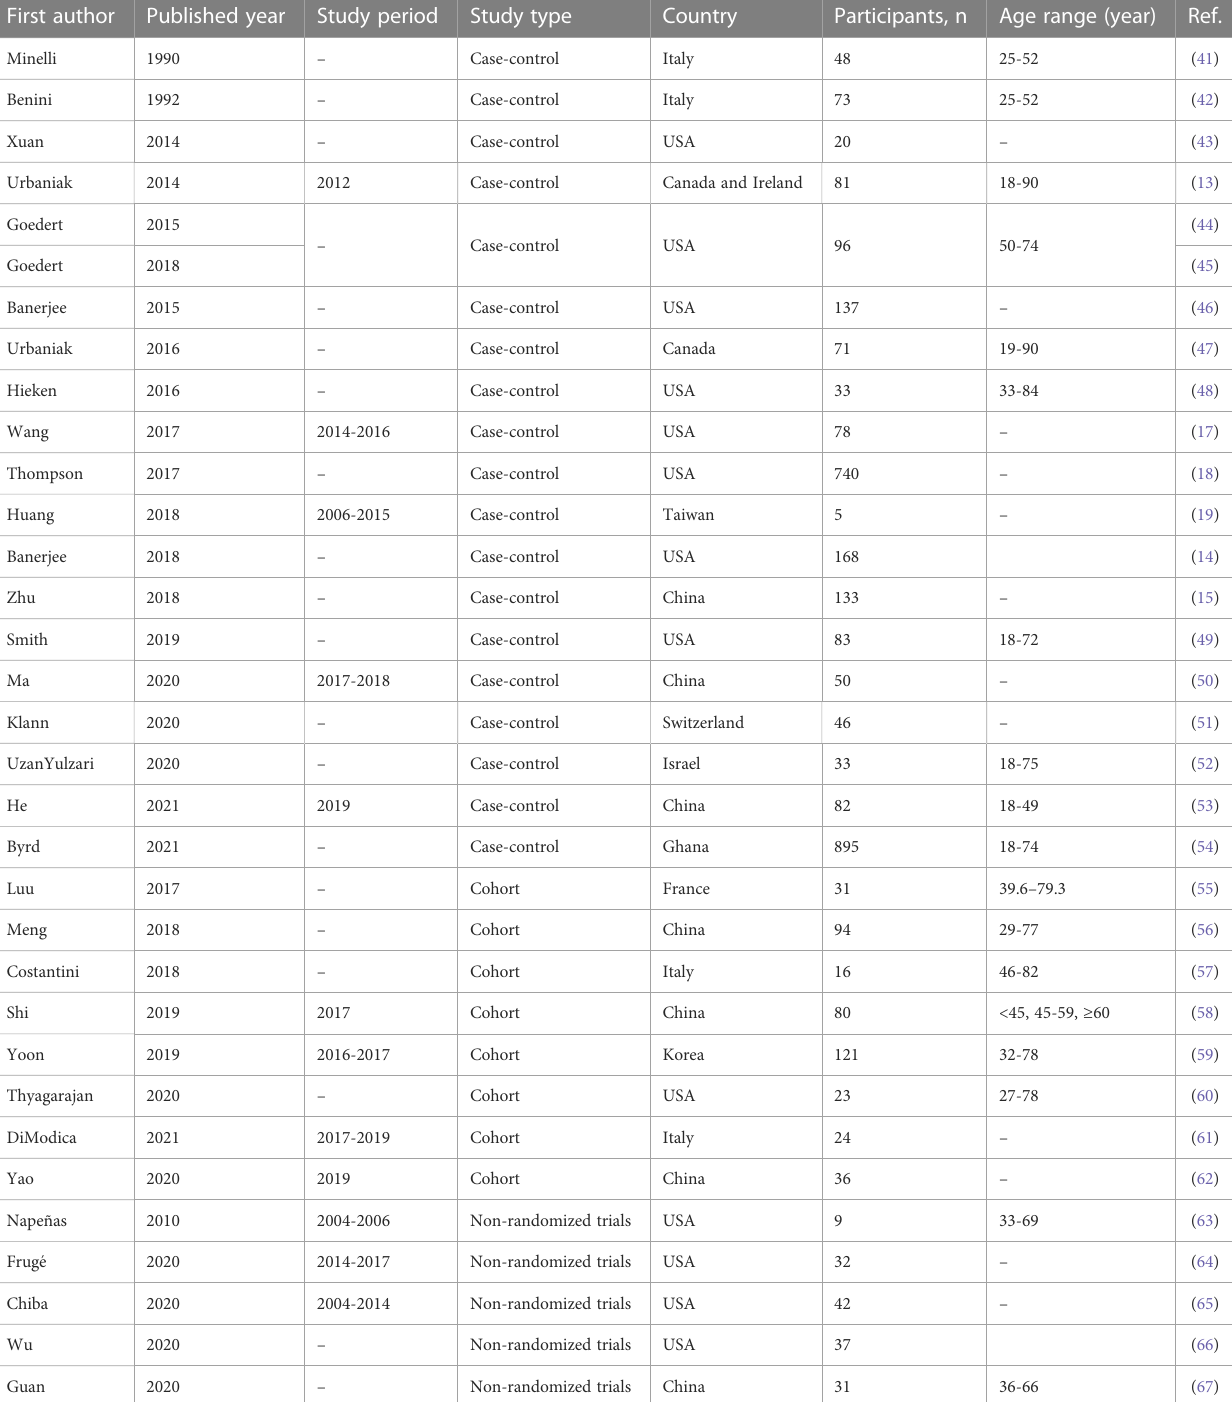
TABLE 1 Baseline characteristics of the included